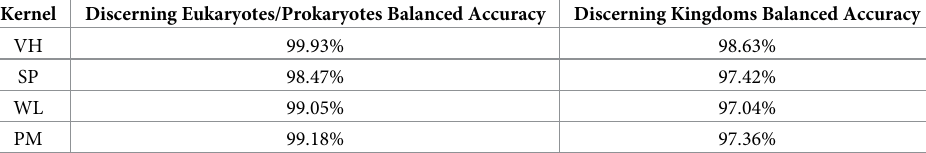
Table 2. Whole dataset test: Evaluation of the SVM results for discerning Eukaryotes/Prokaryotes and